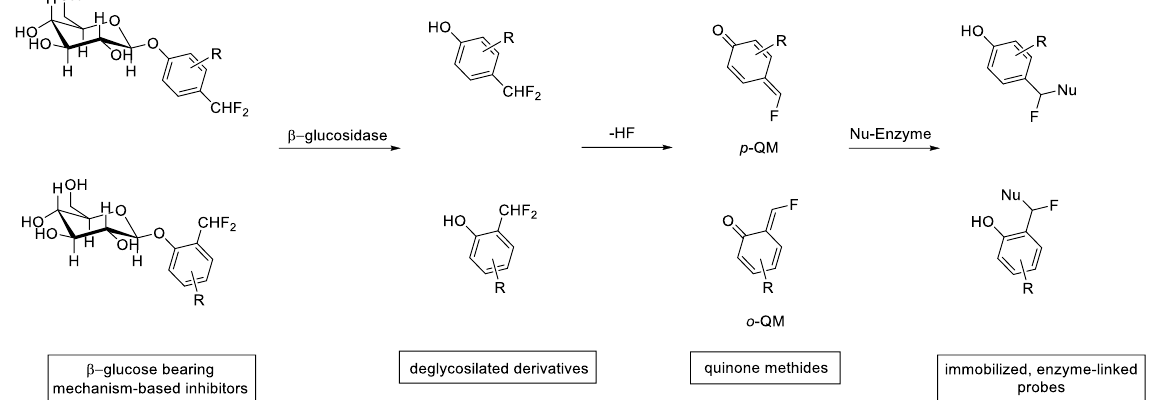
Figure 2. General structure of the ortho - and para -(difluoromethyl)aryl- β -glucosides, activation cascade upon β -glucosidase activity, and the subsequent ligation with a nucleophilic side chain of the enzyme of interest (“Nu - Enzyme”).